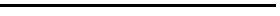
Table 7 Linguistic ratings of the benchmarking for IRoP